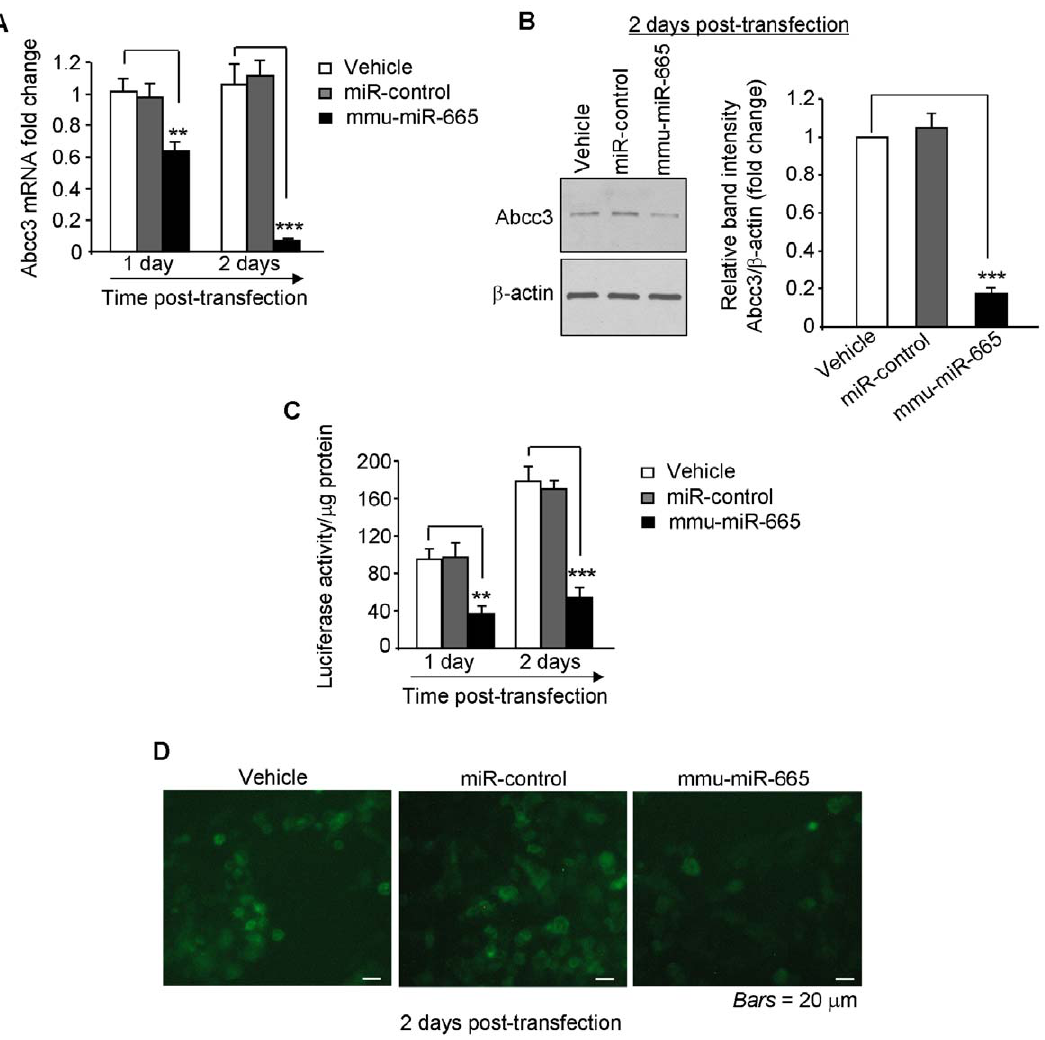
Figure 3. Mmu-miR-665 inhibits Abcc3 expression by directly targeting the Abcc3 mRNA 3 9 -UTR. (A, B) Mmu-miR-665 represses Abcc3 expression. RAW 264.7 cells were transfected with vehicle or precursors of miR-control or mmu-miR-665, and Abcc3 expression was assessed by qRT- PCR and Western blot. Bar graphs in B show the relative intensity of blots (left panel) from three independent determinations with values represent means 6 S.E.M. (C, D) Mmu-miR-665 directly targets the Abcc3 mRNA 3 9 -UTR. RAW 264.7 cells were transfected with a luciferase or a GFP vector containing the Abcc3 3 9 -UTR in the presence or absence of mmu-miR-665. Luciferase activity (C) and fluorescent intensity (D) were determined. Values represent means 6 S.E.M. (n=6/group; * P , 0.05; ** P , 0.005; *** P ,